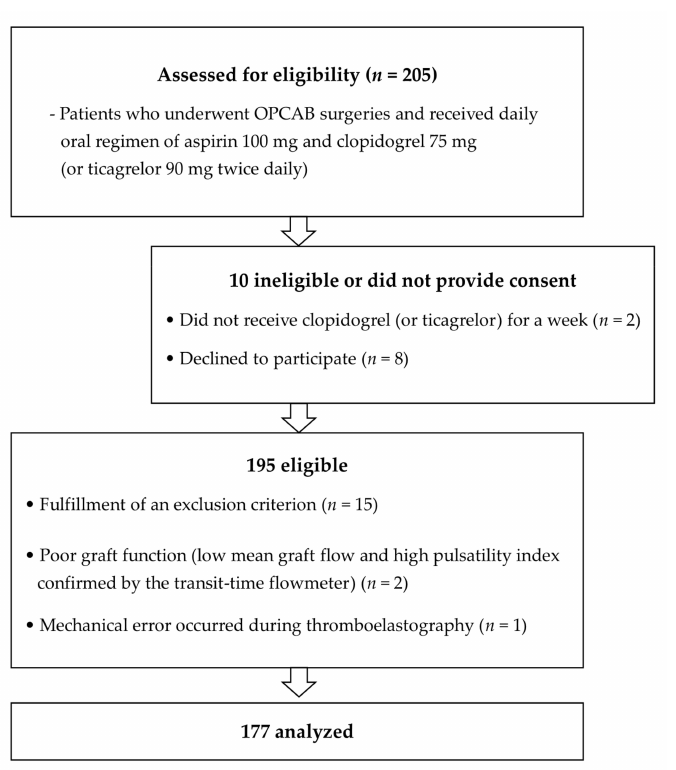
Figure 1. Patient enrolment into the study. The figure illustrates the inclusion and exclusion criteria applied in the study and the resulting number of patients that were finally analyzed. OPCAB, off-pump coronary